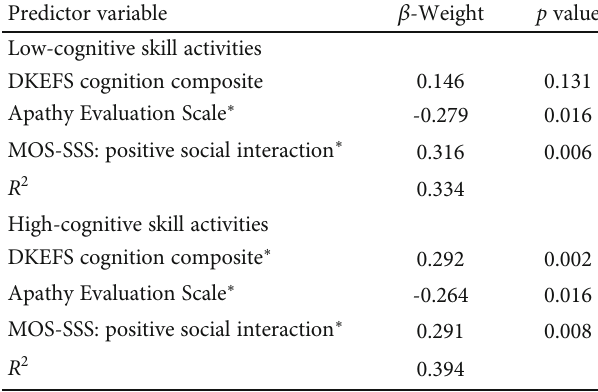
Table 6: Multiple regression results for percent retained participation in low-cognitive skill and high-cognitive skill activities.